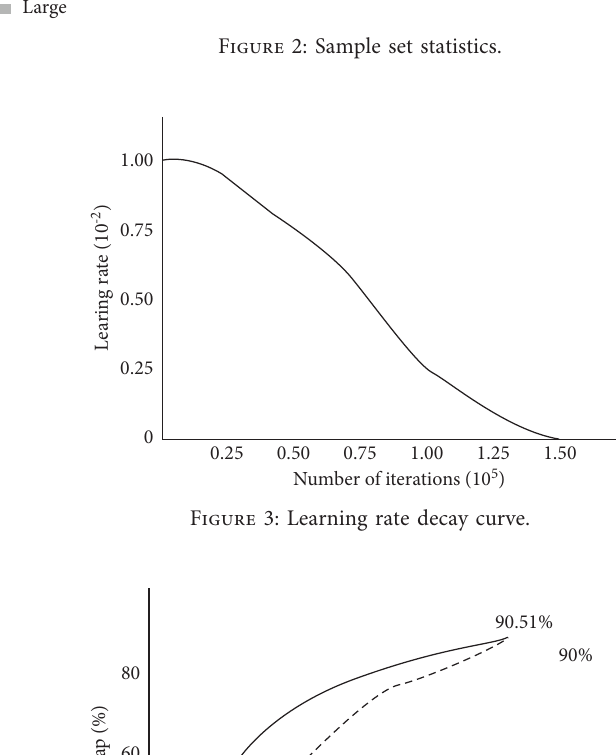
Figure 2: Sample set statistics.